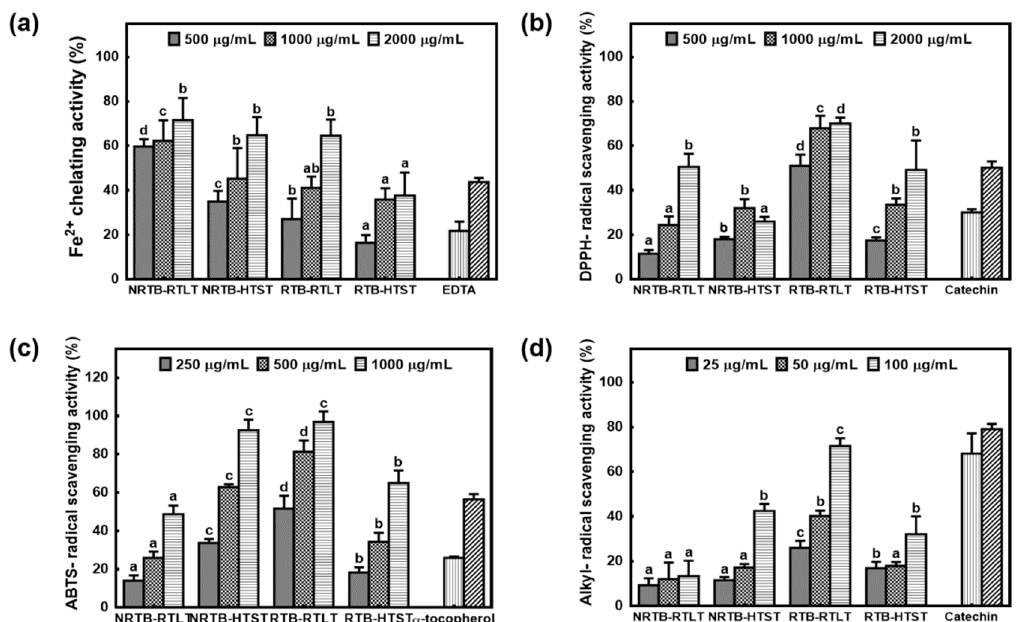
Figure 2. Antioxidant activities of TB teas. ( a ) Fe 2+ -chelating activities, ( b )